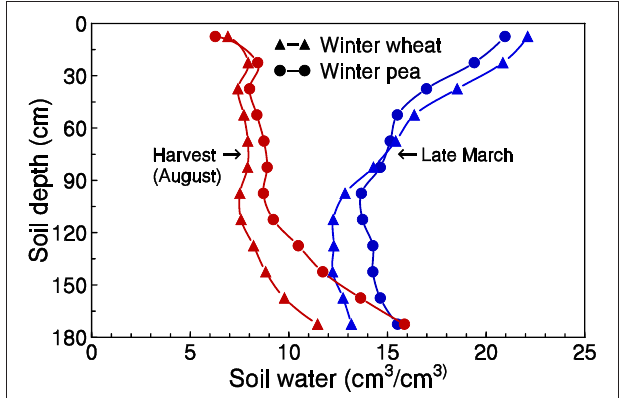
FIGURE 1 | Soil volumetric water content to a depth of 180cm in early August after harvest of winter pea and winter wheat (red lines on left) and overwinter soil water recharge following these two crops measured in late March (blue lines on right). Data are averaged over 5